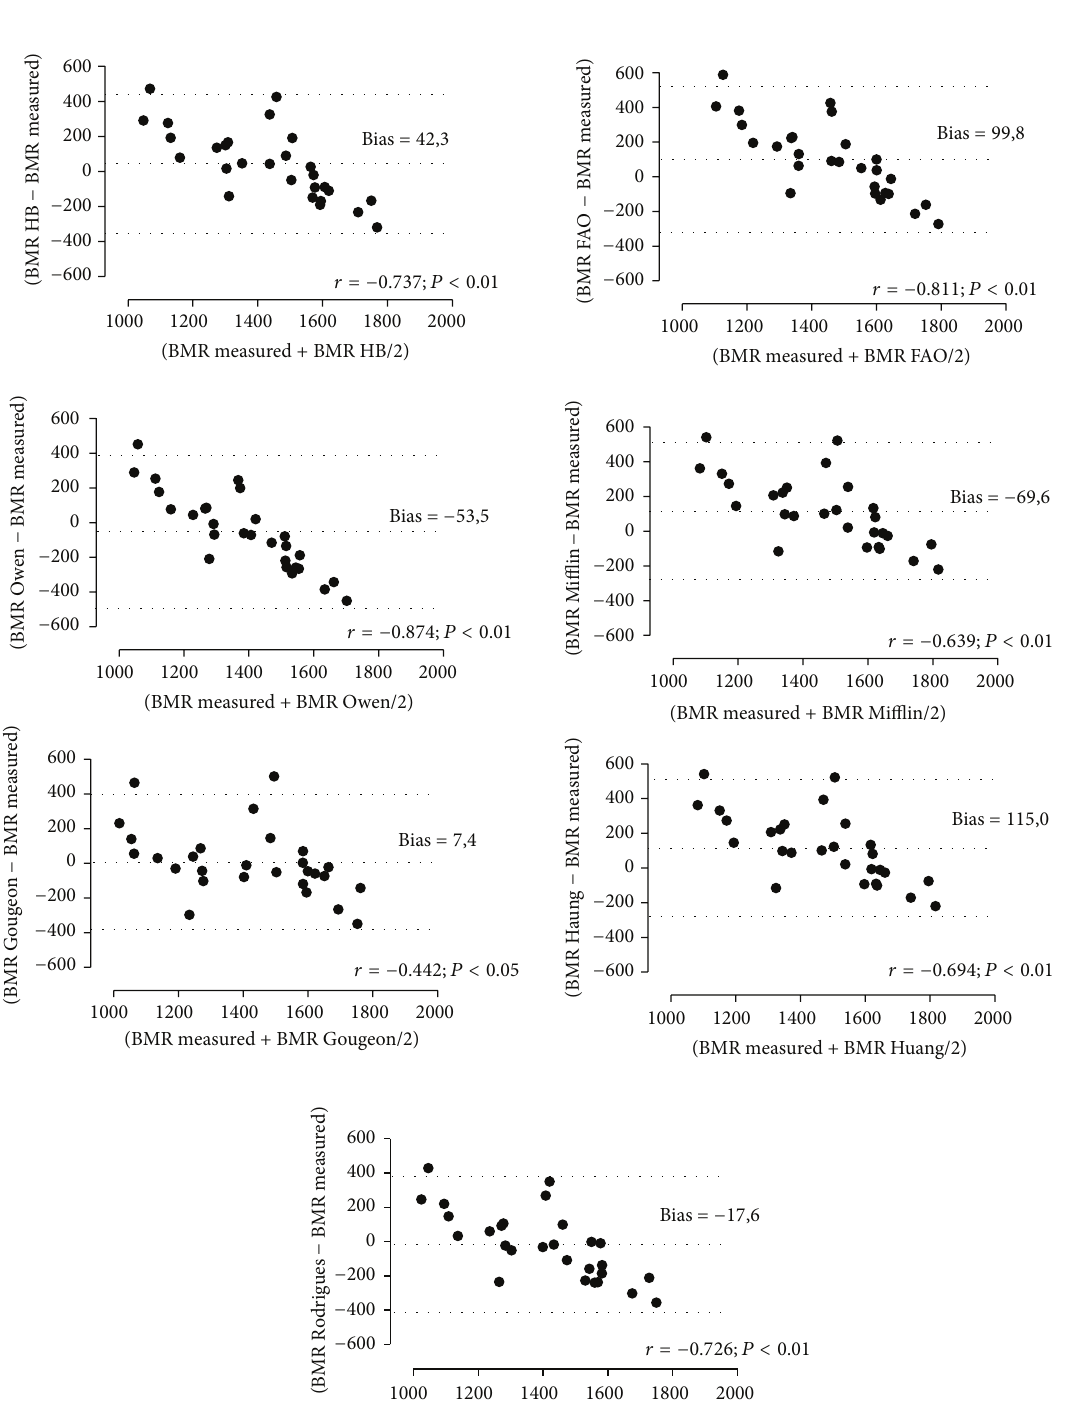
Figure 1: Analysis of Bland and Altman association and the difference between the estimated and measured BMR and the difference between the two methods in women with type 2 diabetes mellitus. BMR: basal metabolism rate; HB: Harris e Benedict; FAO, FAO/WHO/UNU; 𝑟 : Pearson’s correlation